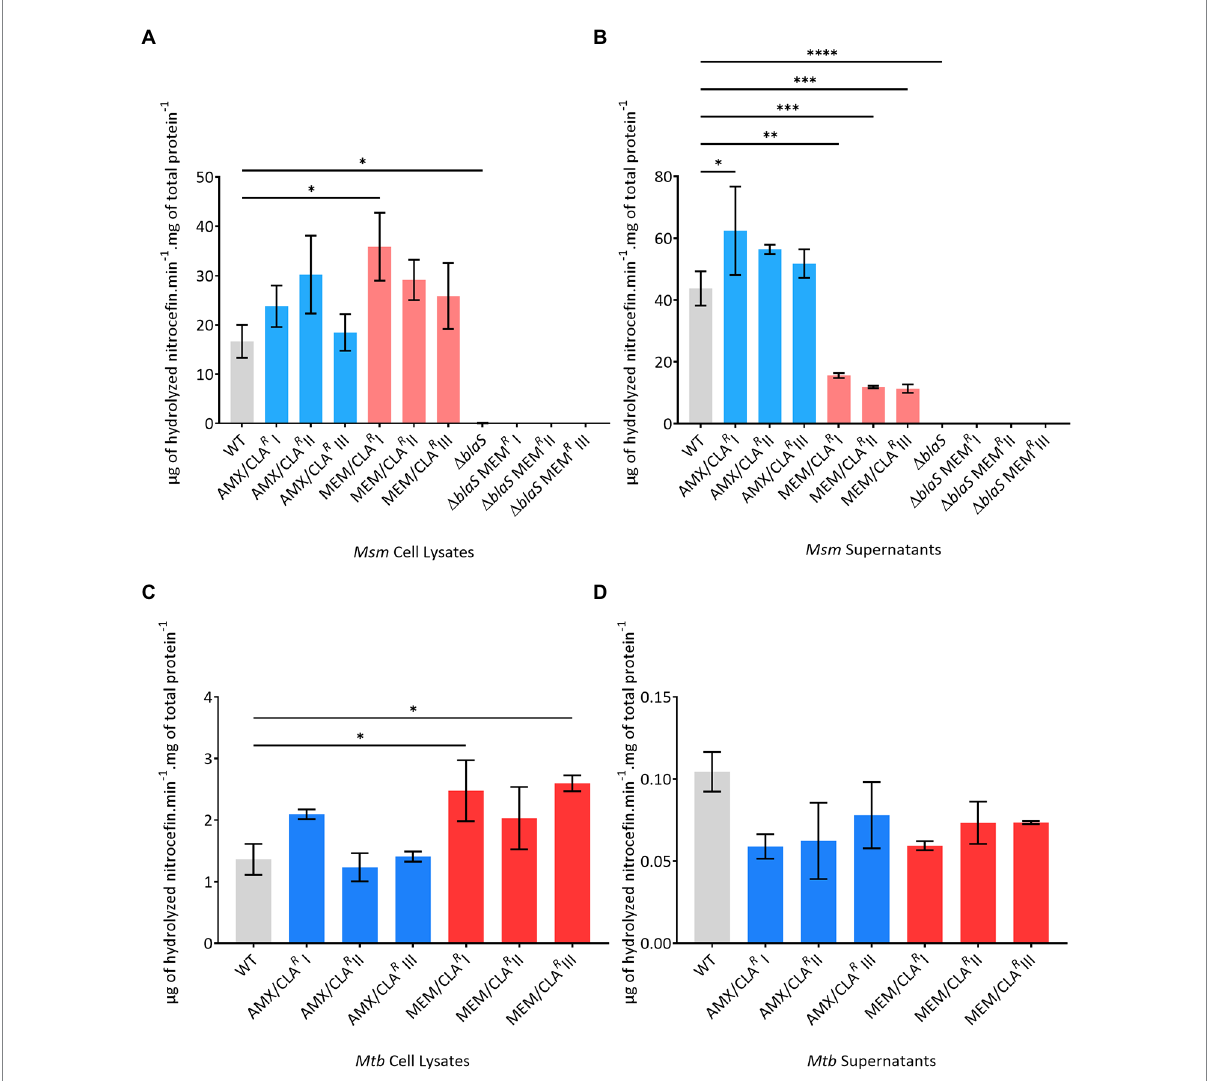
FIGURE 4 Beta-lactamase activity of the Msm and Mtb parental strains or resistant isolates, selected with amoxicillin or meropenem. (A) Msm cell lysates. (B) Msm supernatants. (C) Mtb cell lysates. (D) Mtb supernatants. Beta-lactamase activity is expressed as μ g of hydrolyzed nitrocefin per min per mg of total protein. The assay was performed with two biological replicates for each isolate. Mean values were calculated and error bars express standard deviations. The significance of the differences between samples of resistant derivatives and the wild type (WT) was determined using an ANOVA test: *when p ≤ 0.05; ** when p ≤ 0.01; ***when p ≤ 0.001; ****when p ≤ 0.0001. AMX, amoxicillin; CLA, clavulanic acid; MEM,